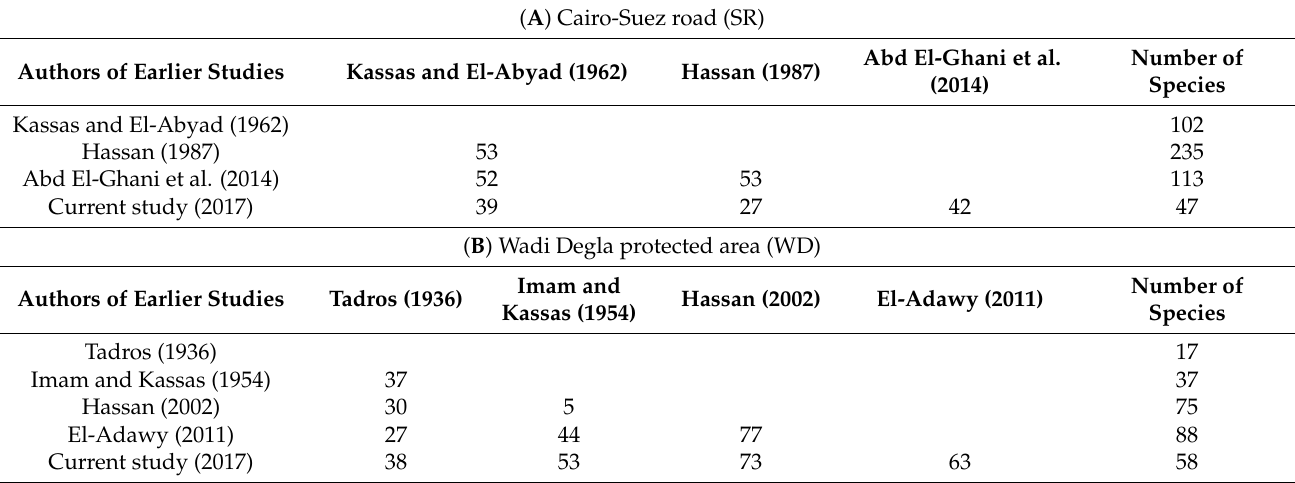
Table 1. Comparison between the numbers of species recorded and Sørensen’s similarity indices between the current and earlier studies in the two areas under